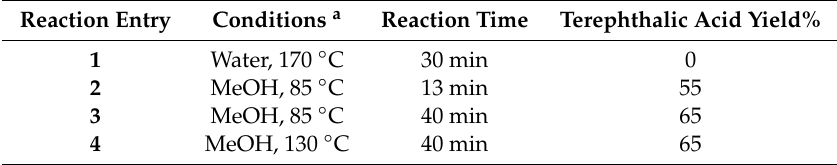
Table 2. Microwave reactions for the depolymerization of poly(ethylene terephthalate).